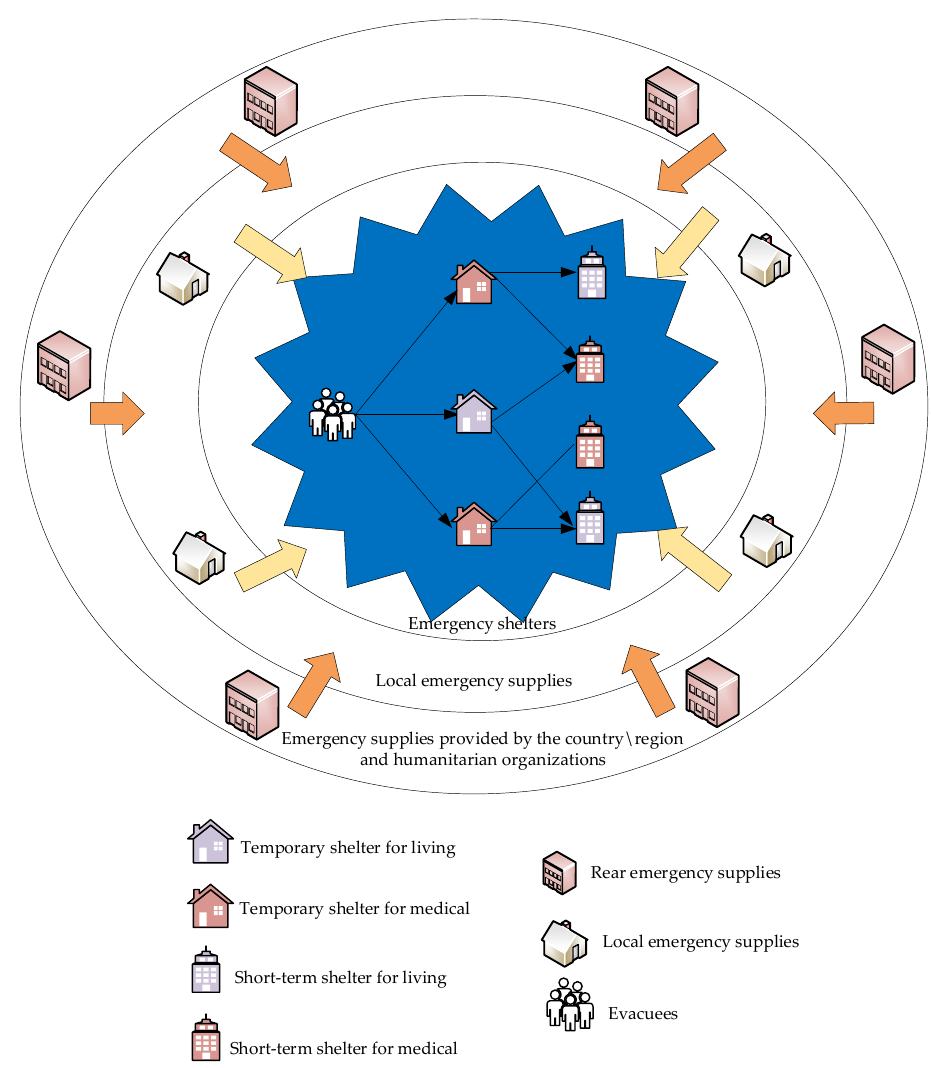
Figure 2. The framework of the emergency shelter location – allocation.